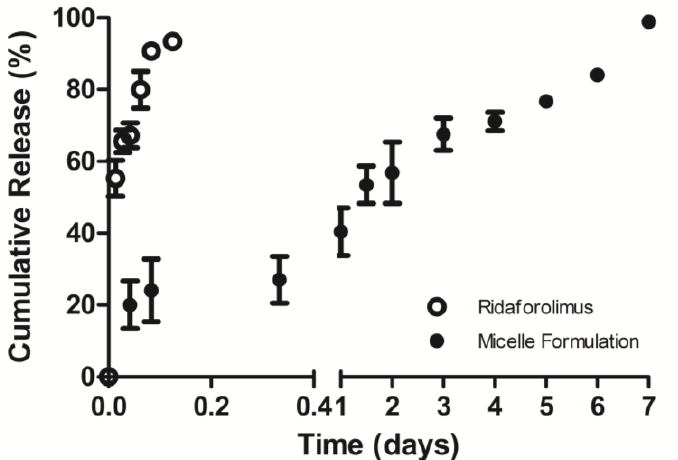
Figure 3. Release profile of ridaforolimus in PEG-DSPE drug in PBS (○) (mean ± SD) ( n =